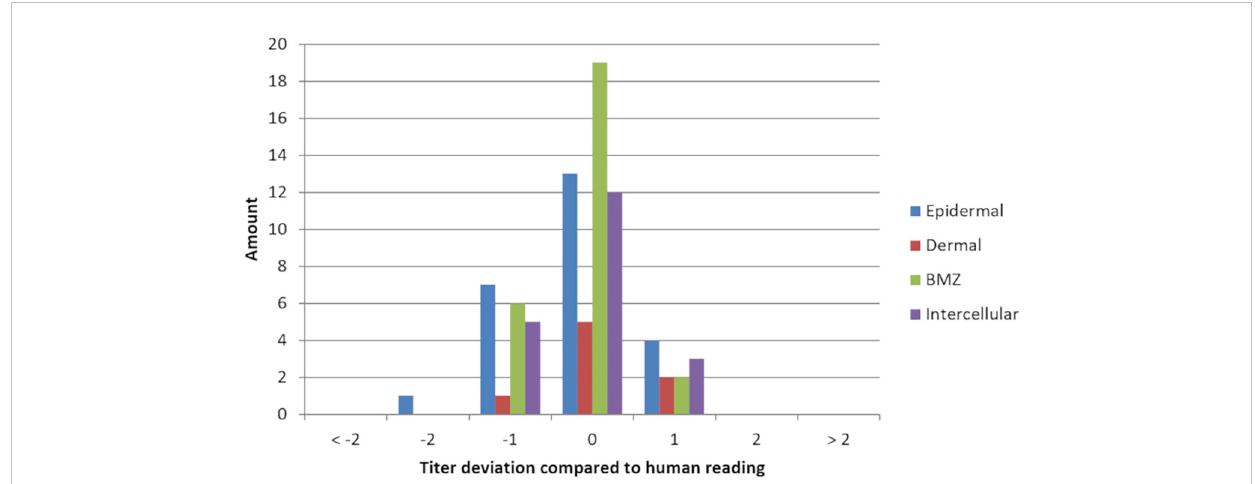
FIGURE 7 Titer deviation of each pattern compared to the evaluation by an experienced reader of indirect immuno fl uorescence images. Titer deviation was only calculated in samples where the algorithm and conventional reading detected the same pattern. The reading by experienced personnel was used as a reference. A negative deviation indicates an underestimation of the titer steps, a positive deviation an overestimation by the